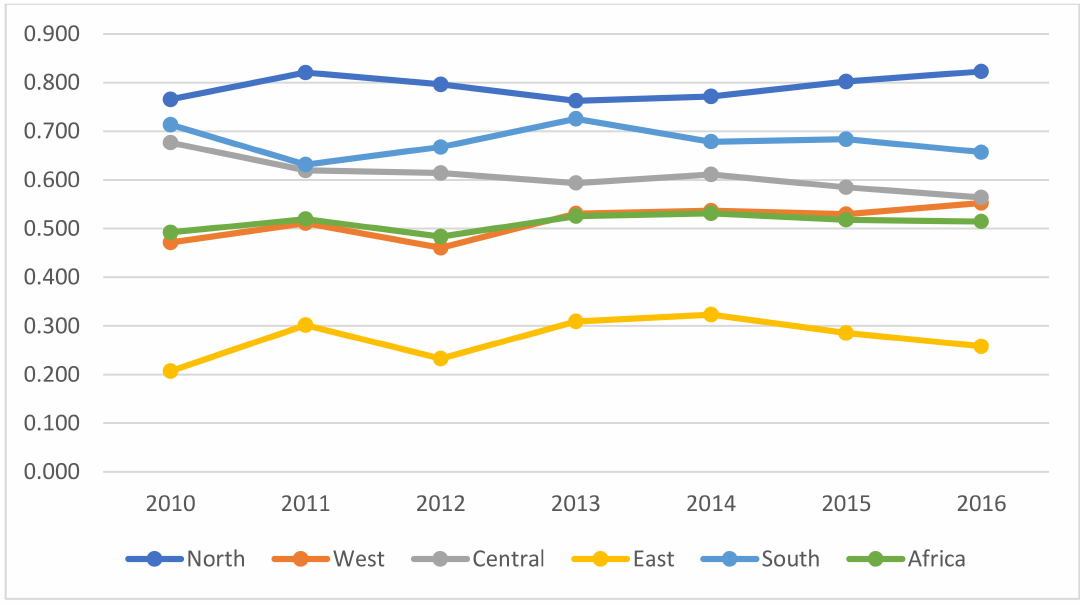
Figure 4. Annual mean trends TGR about DSTFEE in